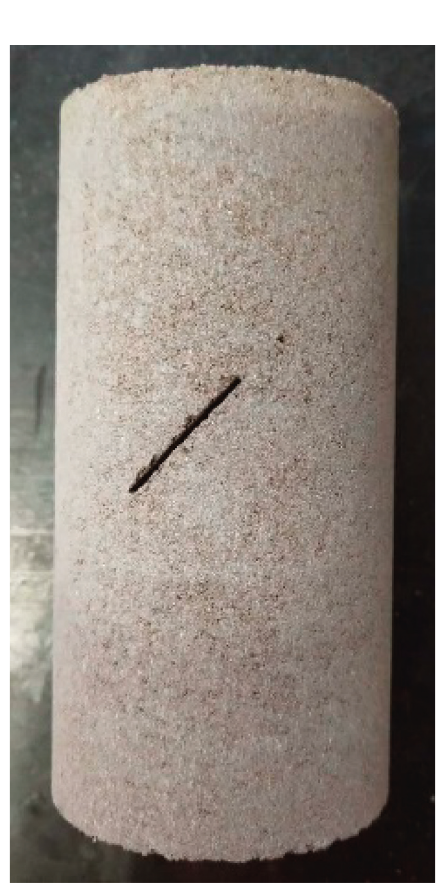
Figure 2: The prepared